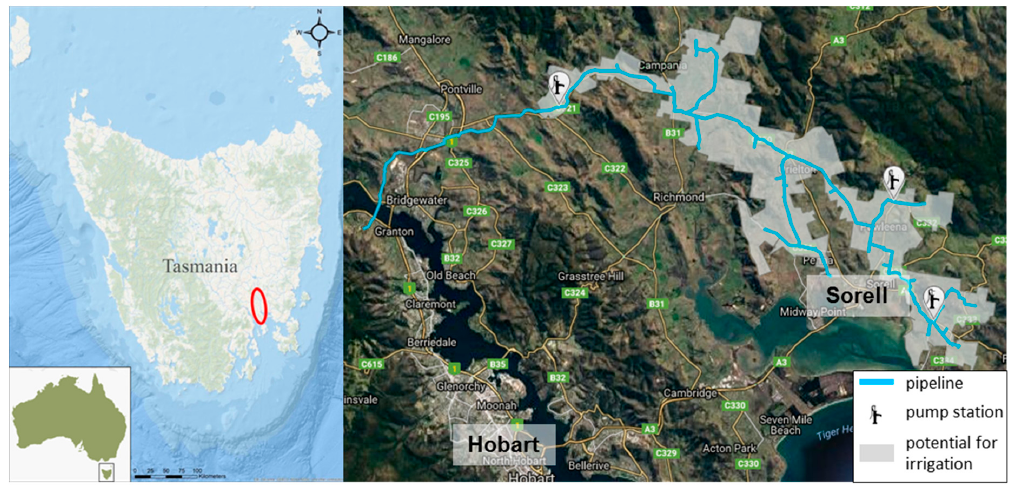
Figure 1. Case study area of the South-East Irrigation Scheme Phase 3 (SE3) district in south-east Tasmania, Australia. The SE3 image was adapted from